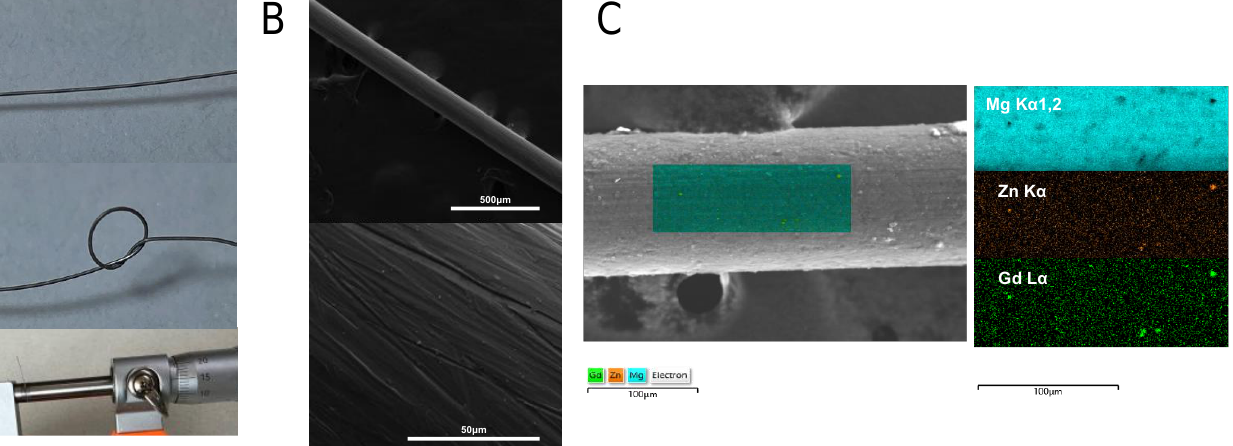
Figure 1. SEM/EDS of ZG21 alloy wire. ( A ) The gross look of the wire and the diameter measurement of the wire; ( B ) SEM image amplified by 200 times and 3000 times; ( C ) element distribution detected by the EDS map scanning.